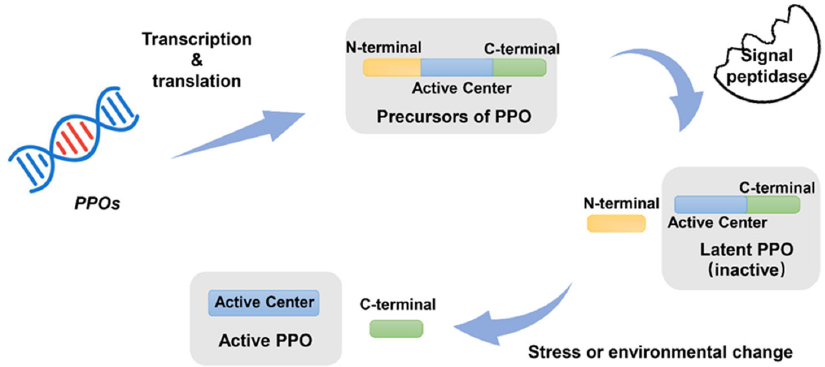
Figure 2. The precursor of PPO was synthesized from PPO genes. Then, the N ‐ terminal transit peptide sequence would be removed, and a mature latent PPO (inactive) would be generated in the plastid. PPO is activated (active PPO) by cleavage of its C ‐ terminal by a protease under stress or environmental change.